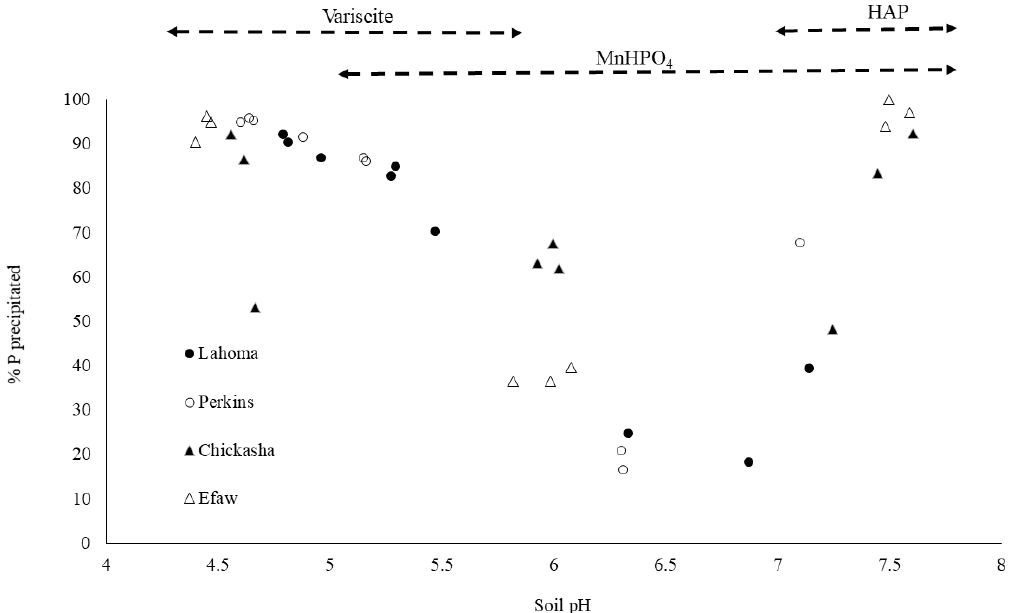
Figure 7. Percent phosphorus (%P) precipitated as a function of pH, and potential solid ‐ phase P minerals as predicted by solution modelling. Minerals listed are not meant to explicitly indicate those specific minerals, only the general presence of Al, Mn, and Ca ‐ related P.